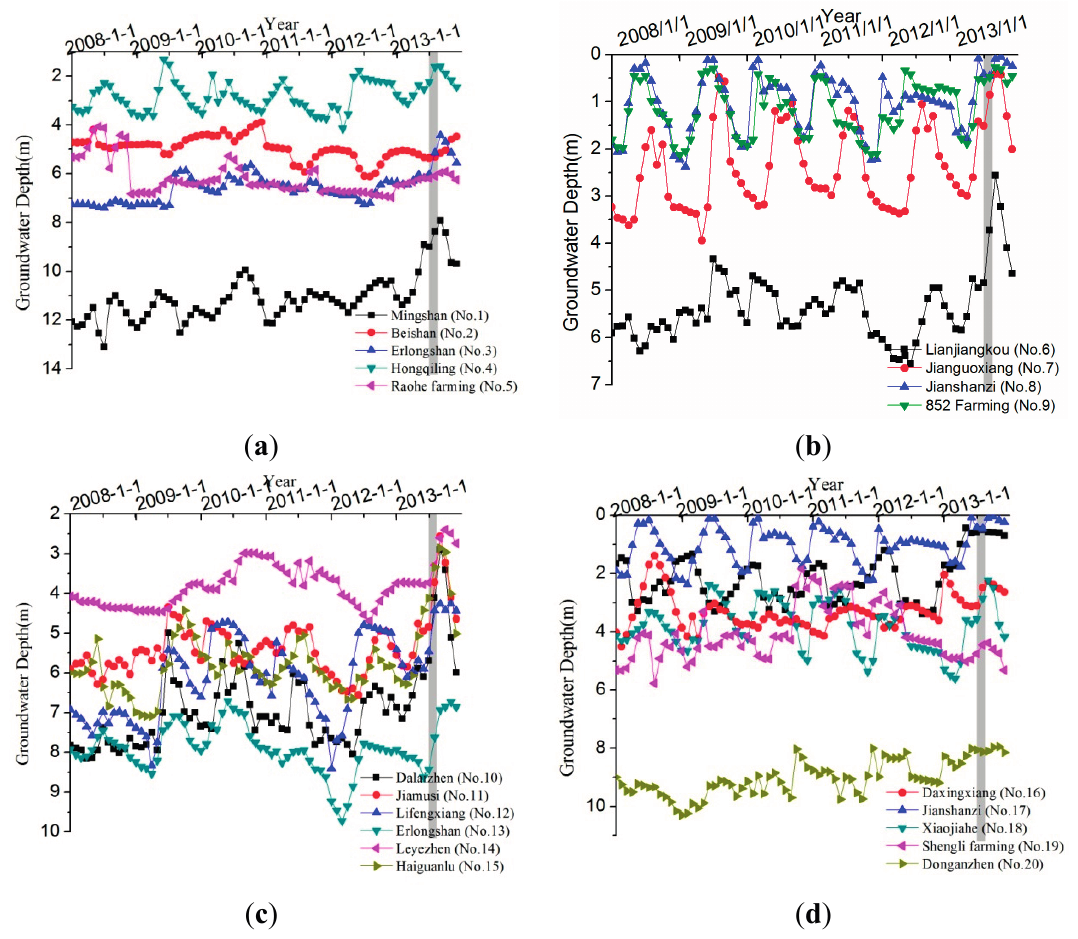
Figure 2. Fluctuation of the groundwater depths along four cross-sections in the Sanjiang Plain, Northeast China from January 2008 to September 2013: ( a ) I 1 ; ( b ) I 2 ; ( c ) I 3 ; and ( d ) I 4 . The gray background stands for the 2013 flood